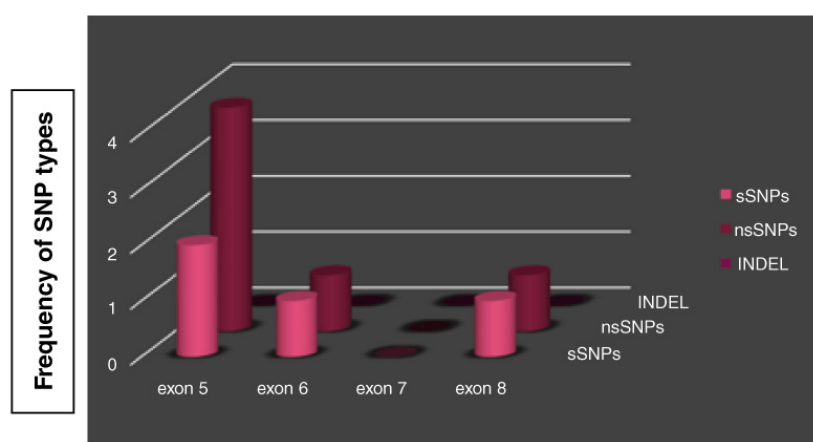
Figure 1. Distribution of TP53 coding synonymous SNPs (sSNPs), coding non-synonymous SNPs (nsSNPs) and INDEL through exon 5–8 in P53